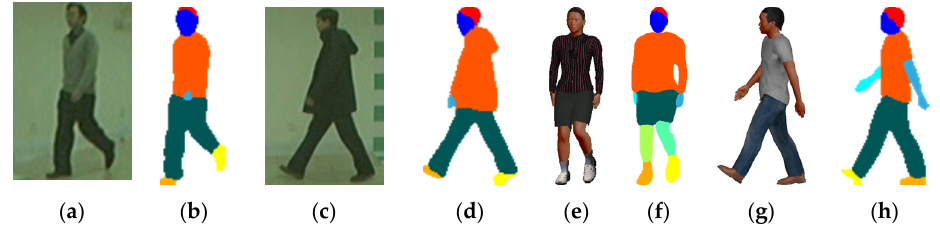
Figure 3. ( a ) and ( c ): RGB gait images from CASIA B gait dataset ( e ) and ( g ): rendered RGB gait images of synthesized 3D gait model with virtual dressing, and ( b ), ( d ), ( f ), and ( h ): the corresponding semantically parsed images.